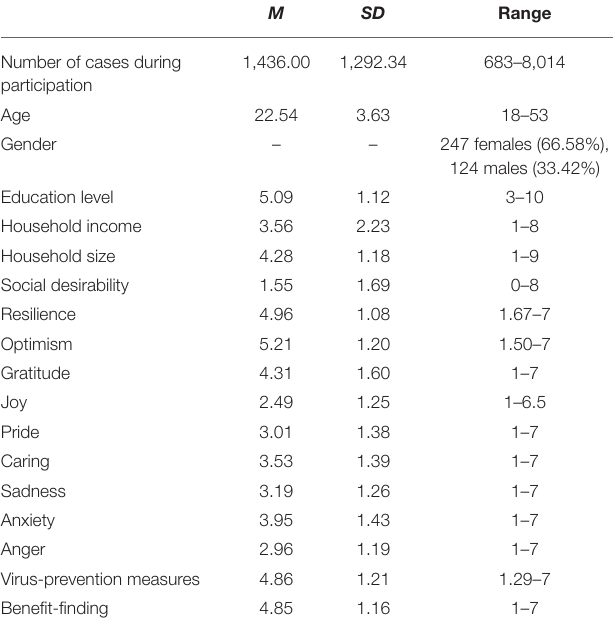
TABLE 1 | Descriptive statistics for all key